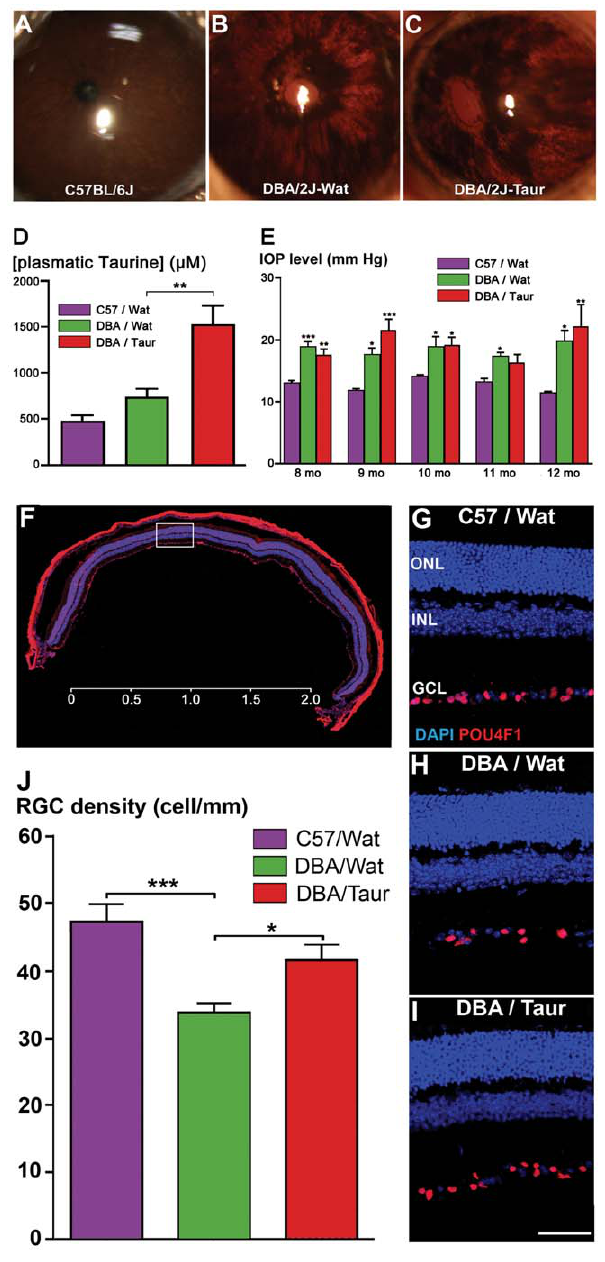
Figure 4. Taurine supplementation prevents RGC degeneration in DBA/2J mice, a genetic animal model of pigmentary glaucoma. A–C) Iris dispersion in DBA/2J mice. Normal iris in C57BL/ 6J mouse (A) and iris with pigment dispersion in DBA/2J mice